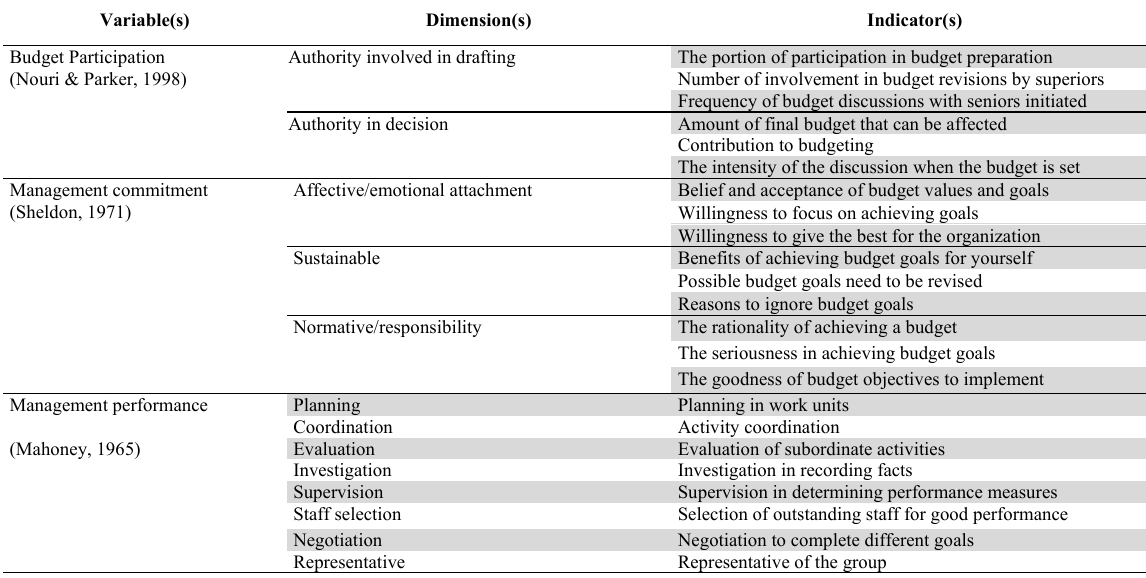
Operationalization of Variables Variable(s) Dimension(s) Indicator(s) Budget Participation Authority involved in (Nouri & Parker, 1998)